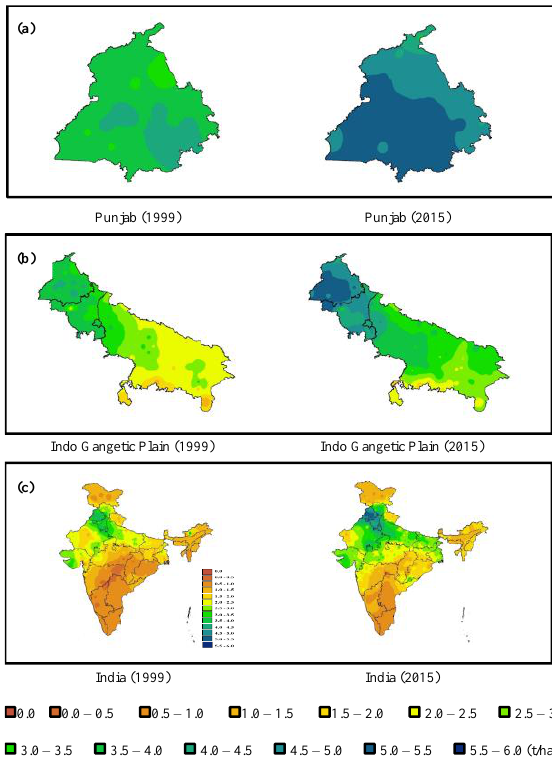
Figure 3 . Change in wheat crop yield between the years 1999 and 2015 in India at three spatial scales: (a) local Figure 5 . Hot and Cold spot results for wheat crop area, (Punjab district); (b) regional (Indo Gangetic plain); and (c) under six different neighbourhood distances : a) 11.5 km; country (India). (b) 28.75 km; (c) 57.5 km; (d) 115 km; (e) 230 km; (f) 575 km. With the increase in the neighbourhood distance, Hot and cold spots become larger and lesser; smaller neighbourhood distances detect trends confined to smaller